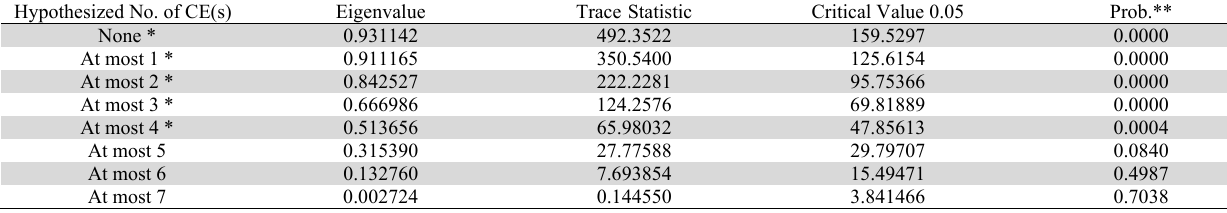
Verify cointegrated relationships between chains (Unrestricted Cointegration Rank Test (Trace) ) Hypothesized No. of